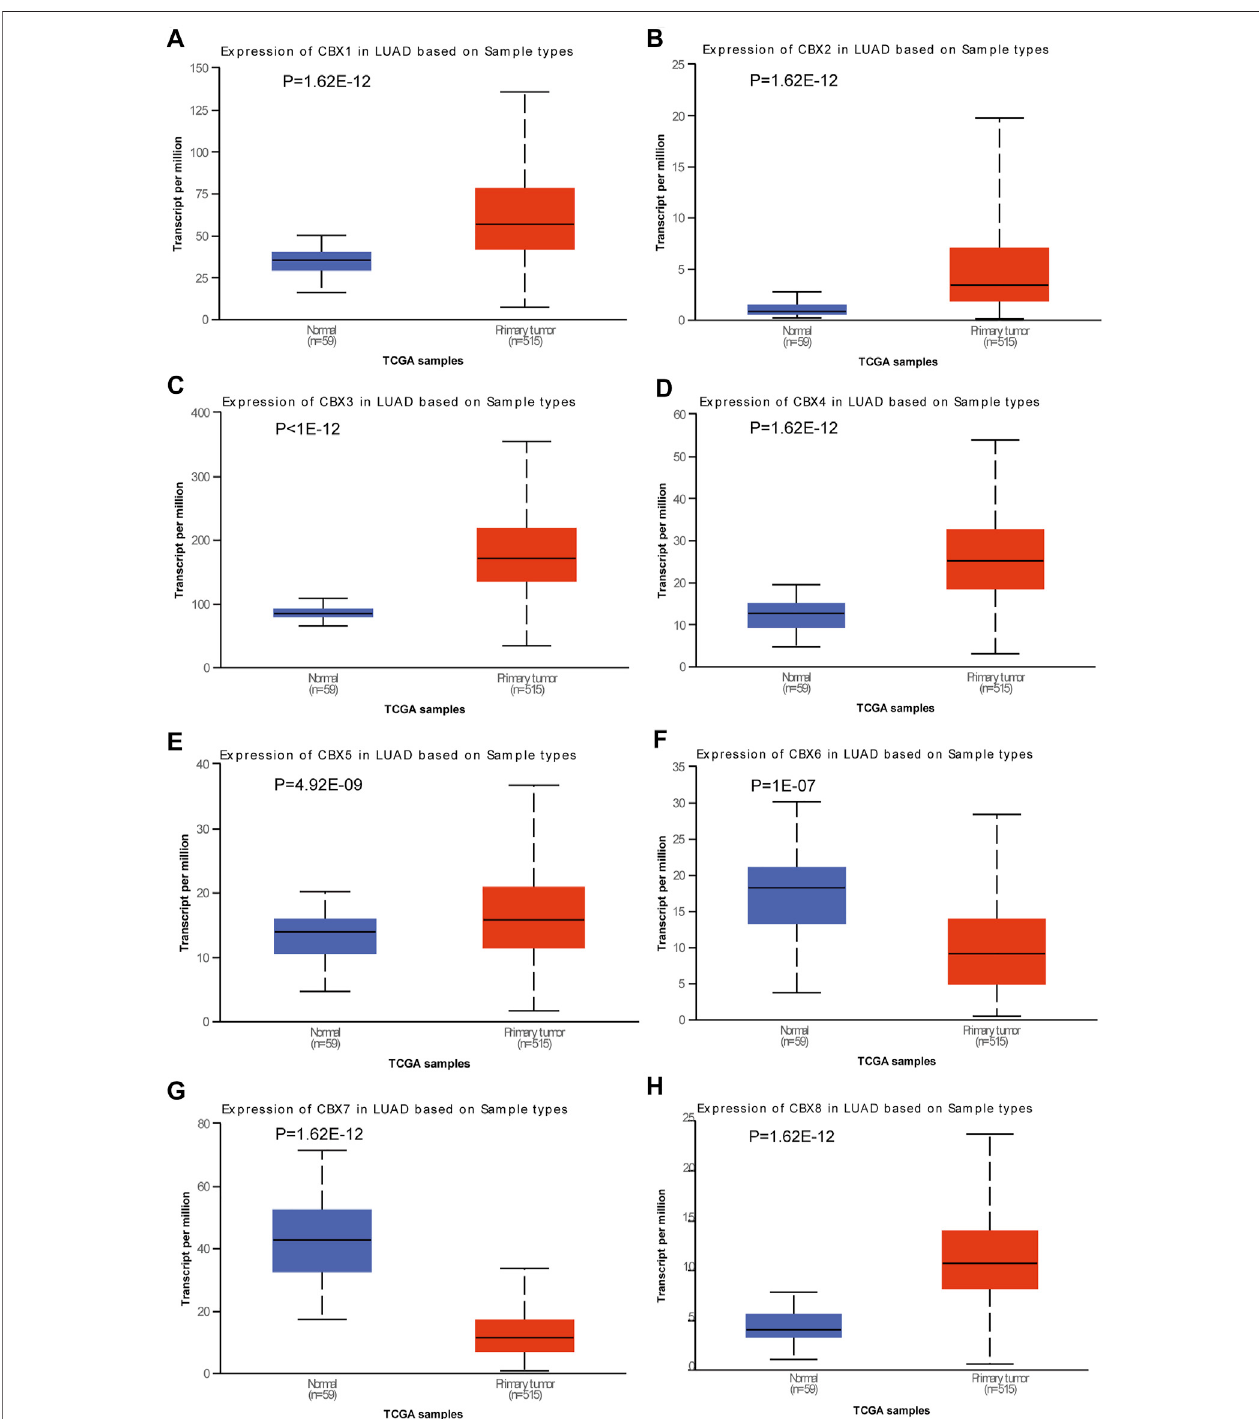
FIGURE 1 | Expression of CBX family members in lung adenocarcinoma (LUAD). Box plots showing the expression of CBX family members in LUAD compared to normal tissues. (A) CBX1, (B) CBX2, (C) CBX3, (D) CBX4, (E) CBX5, (F) CBX6, (G) CBX7, and (H) CBX8. Differences were considered signi fi cant at p < 0.05.